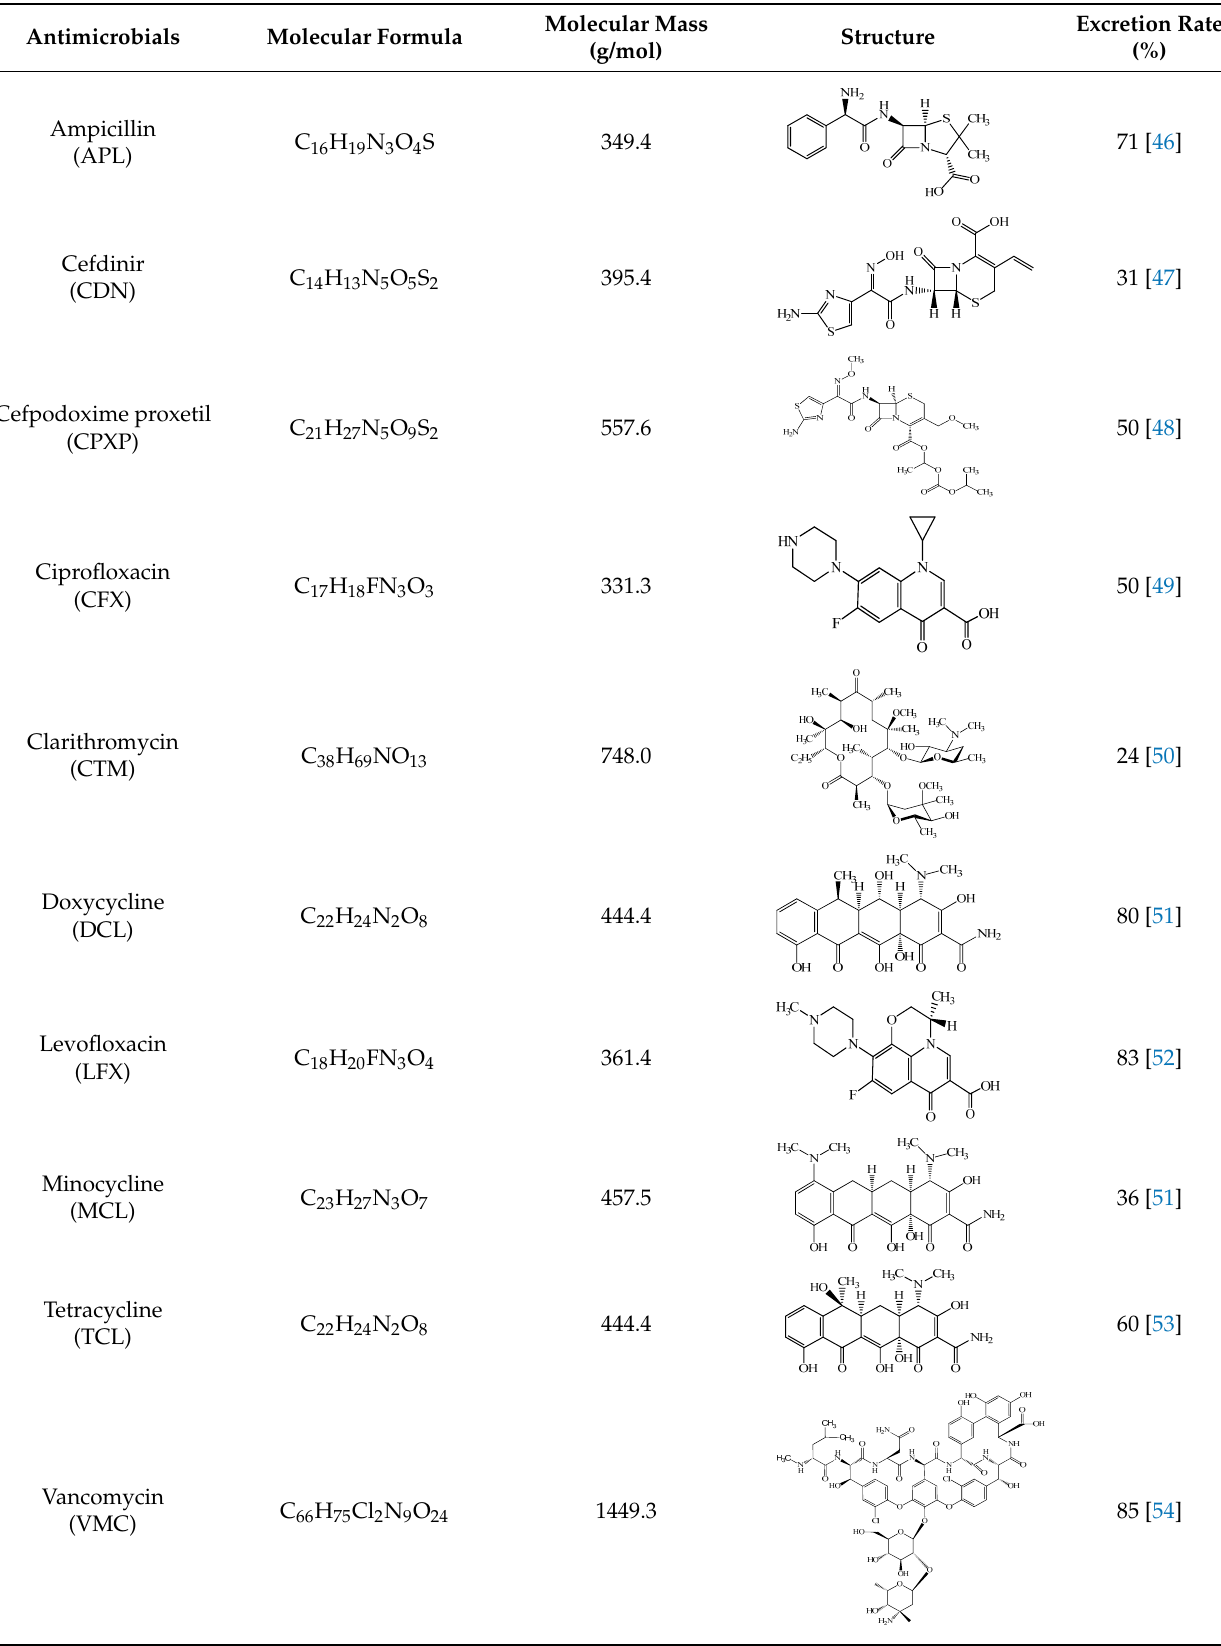
Table 1. Properties of the target antimicrobials examined [46–54].